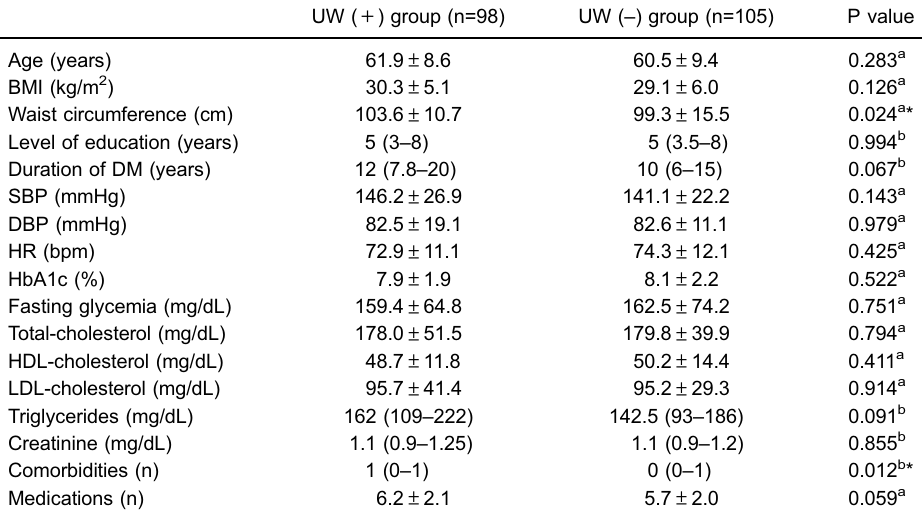
Table 1. Demographic, anthropometric, and clinical characteristics of 203 patients with type 2 diabetes mellitus assessed for the presence of the symptom of unsteady walking